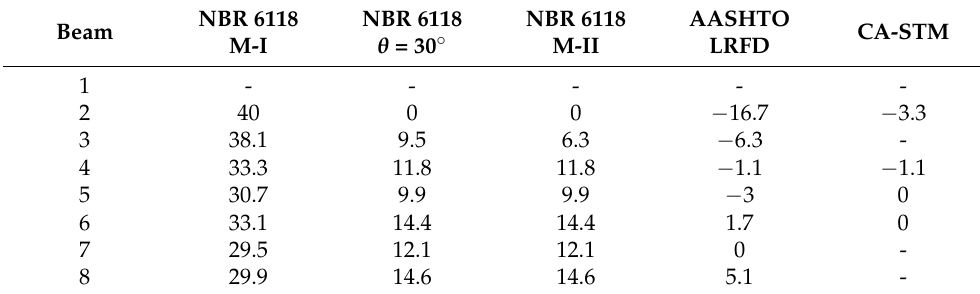
Table 6. Relative errors (%) for the maximum shear force for RC beams from Series